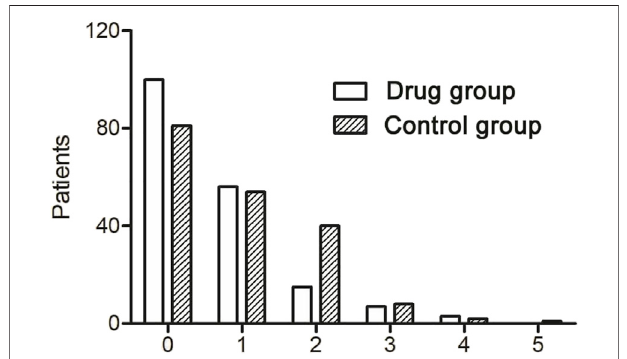
FIGURE 4 | Number of re-exacerbations within 12 months in the two